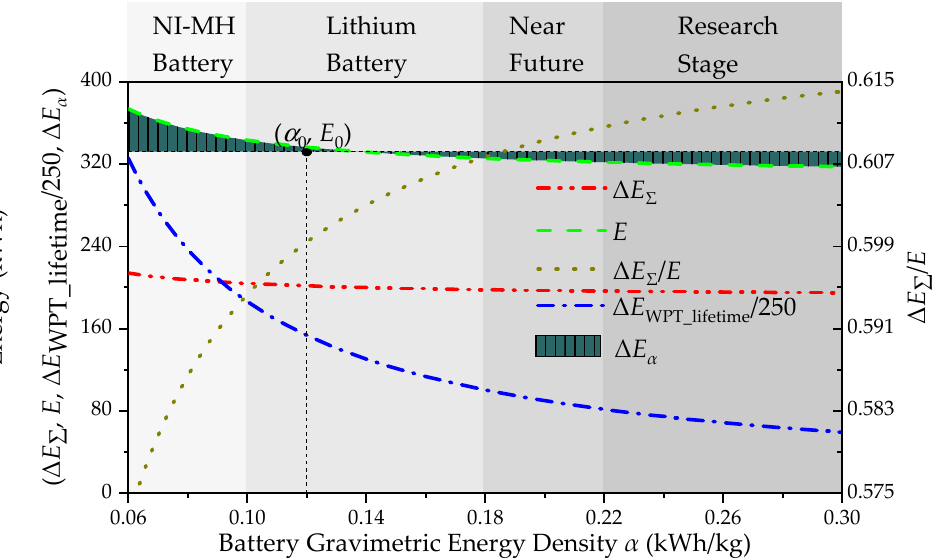
Figure 7. The effects of the battery gravimetric energy density. Figure 7. The e ff ects of the battery gravimetric energy